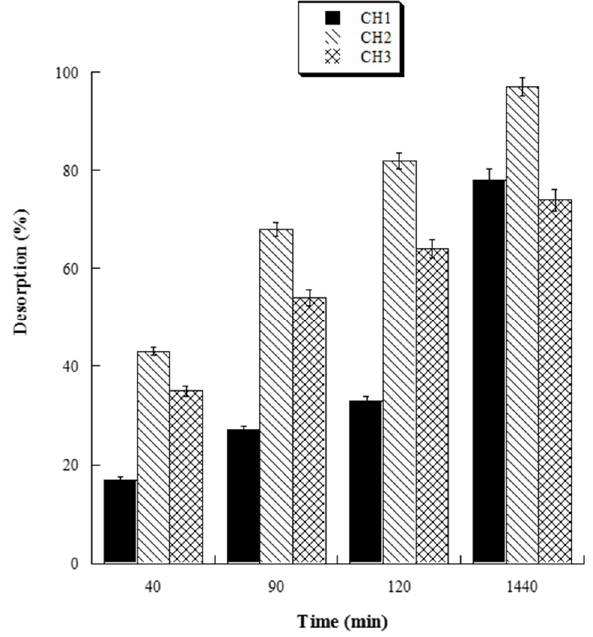
Figure 5. Percentage amount of cumulative GA released from dried HL-3D chitosan-GA at any time point.